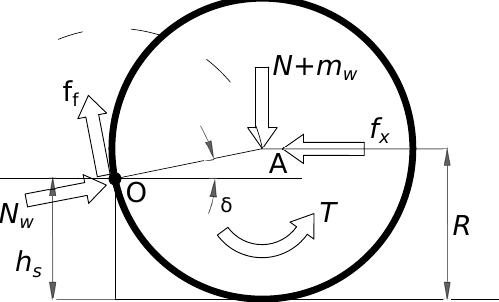
Figure 8. Free body diagram of wheel.